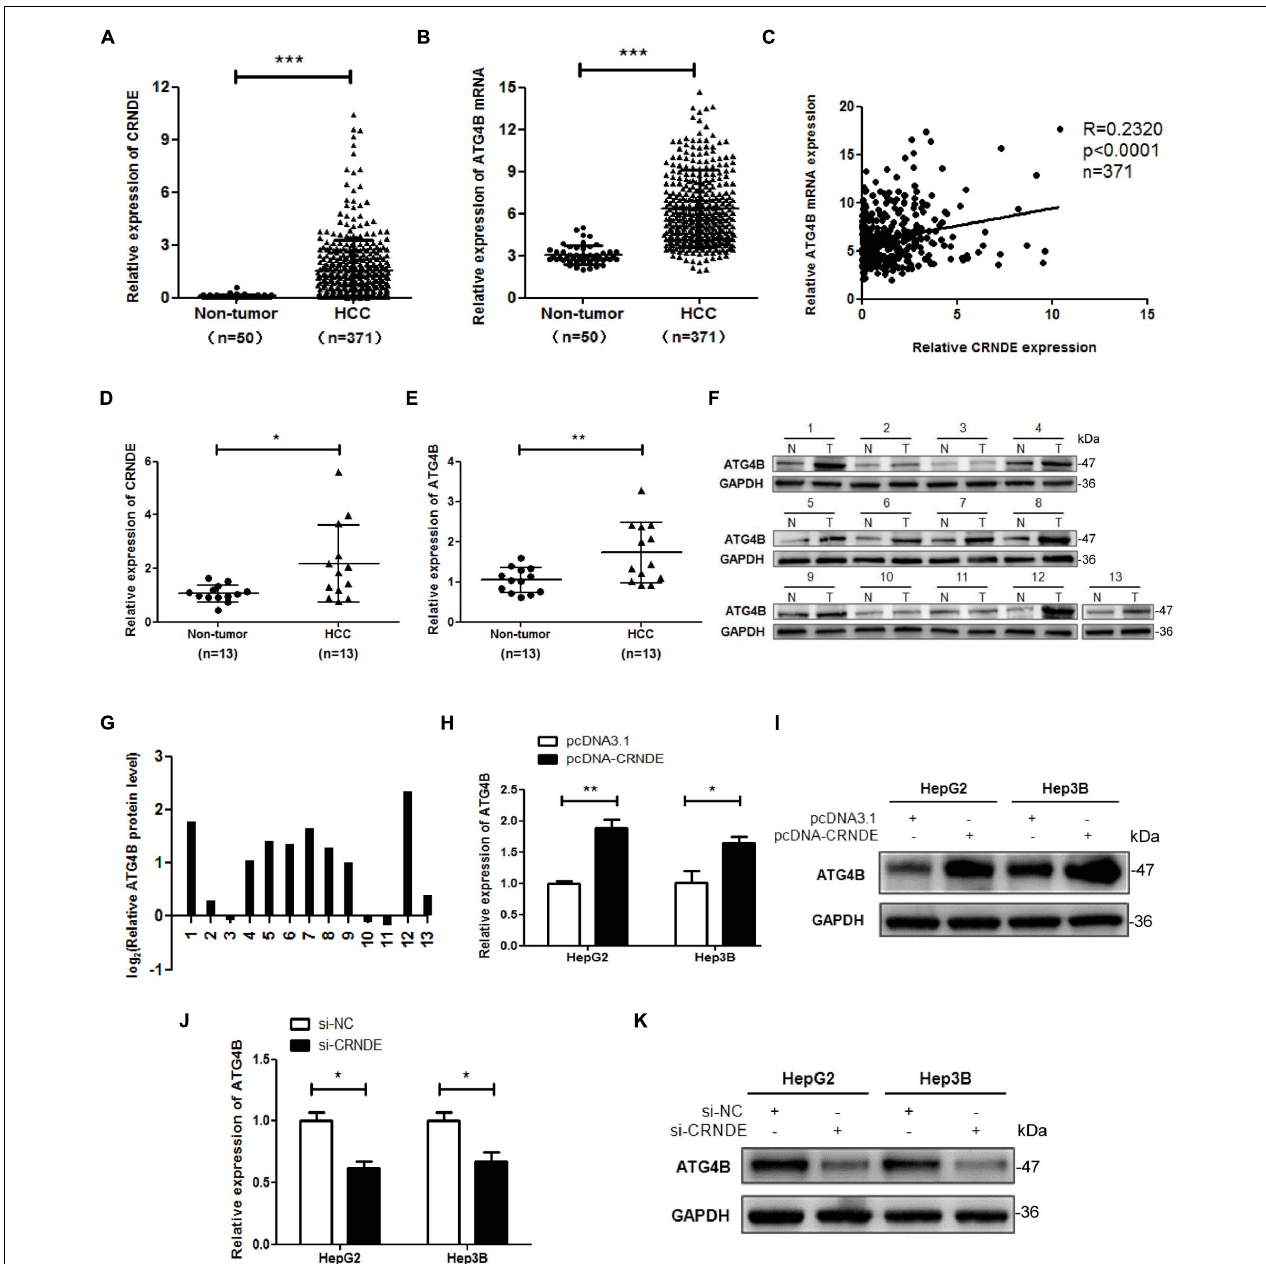
FIGURE 1 | CRNDE elevates ATG4B in HCC cells. (A,B) Expression analysis of CRNDE and ATG4B in HCC tissues and non-cancerous liver tissues using TCGA database. (C) Analysis of the correlation between CRNDE and ATG4B mRNA levels in HCC tissues using TCGA database. (D–F) The levels of CRNDE, ATG4B mRNA and protein in 13 pairs of HCC tissues (T) and the adjacent non-cancerous liver tissues (N) were separately assayed by qPCR (D,E) and Western blot (F) . (G) The protein band density in F was analyzed using Image Lab software and the relative ATG4B protein level (ATG4B/GAPDH ratio) was transformed to Log 2 (T/N). (H–K) HepG2 and Hep3B cells were transfected with pcDNA-CRNDE (or pcDNA3.1) (H,I) or si-CRNDE (or si-NC) (J,K) for 24 h, then the levels of ATG4B mRNA and protein were separately detected by qPCR (H,J) and Western blot (I,K) . pcDNA-CRNDE: CRNDE expression vector; pcDNA3.1: control vector pcDNA3.1(+); si-CRNDE: the siRNA for CRNDE; si-NC: control siRNA; * P < 0.05; ** P < 0.01; *** P < 0.001.